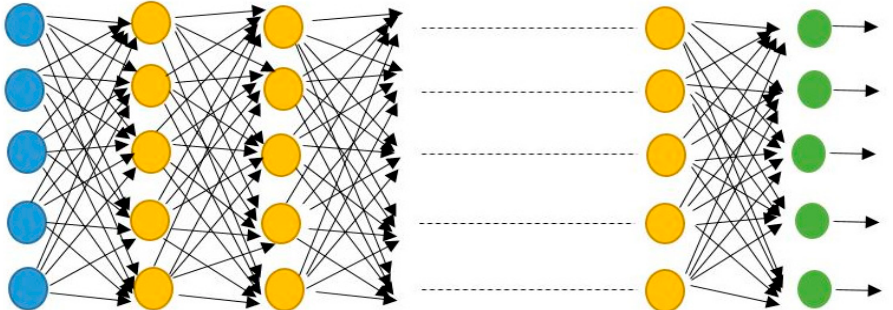
Figure 1. Architecture of a Deep Neural Network.